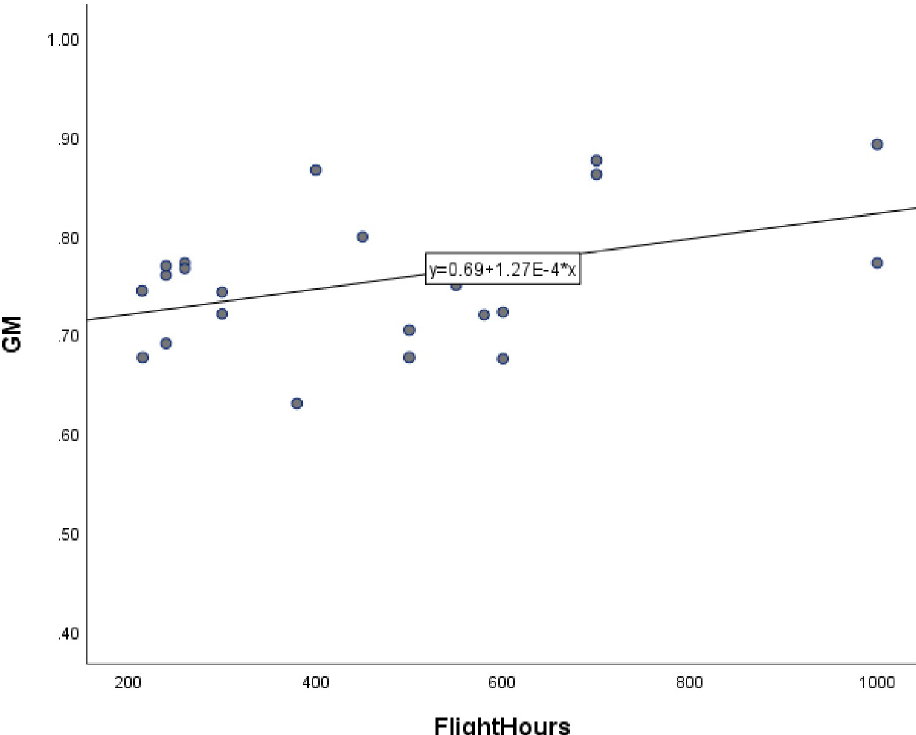
Fig 4. Correlation analysis between pilots’ gray matter volume and flight hours.